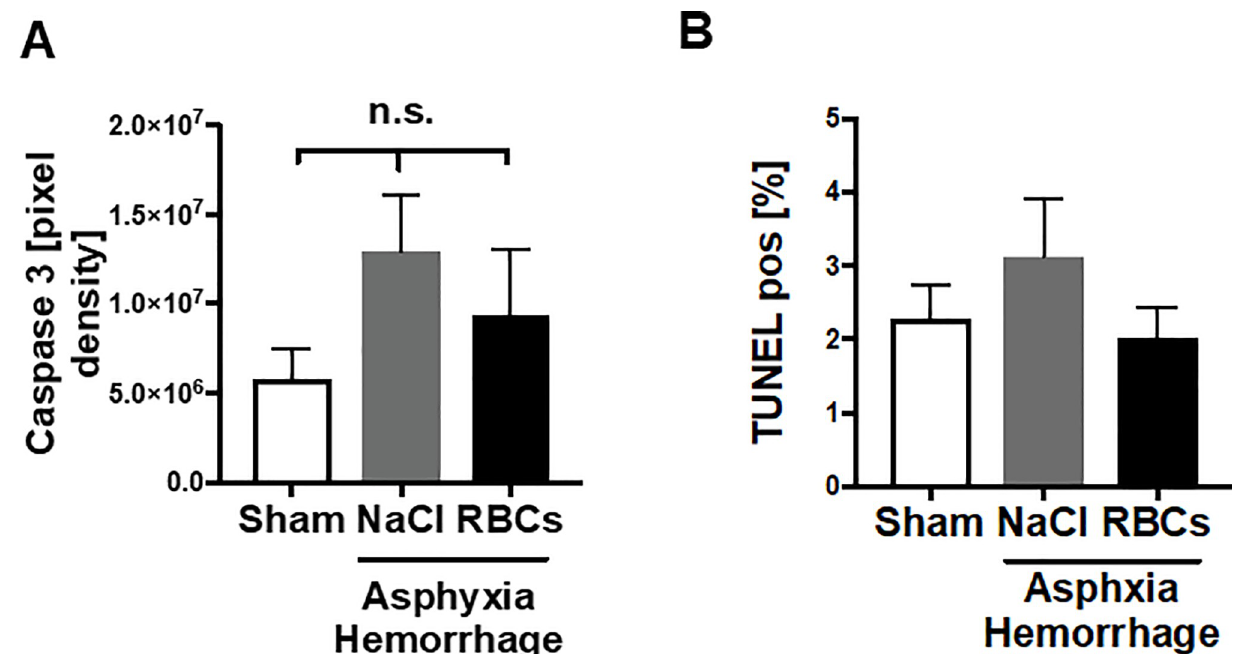
Fig 3. No elevation of apoptotic cells in lung tissue after AH. A) Results from caspase 3 analysis. B) TUNEL positive nuclei in percentage of whole cell count by DAPI staining; n.s. = not significant; graphical representation as mean ± SEM, NaCl n = 6, RBC n = 9, sham n = 6.